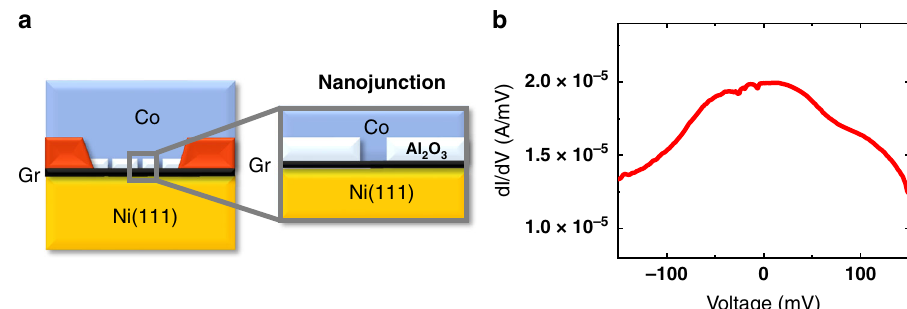
Fig. 3 Alternative Al 2 O 3 growth. a Changing ALD growth parameters leads to the reduction of the wetting of the Al 2 O 3 fi lm on graphene. b This translates to a clear signature in transport measurements as shown by the disappearance of tunneling behavior in the d I /d V (lock-in ac + dc measurements). A direct graphene/Co contact is thus de fi ned over a small effective area, allowing the Ni(111)/graphene/Co spin transport properties to be